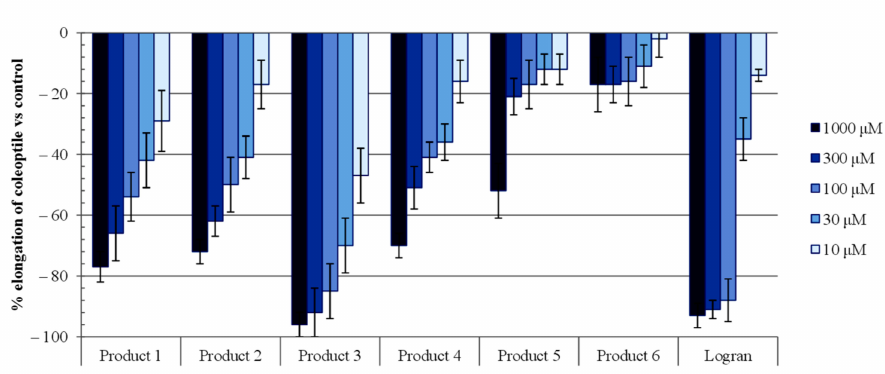
Figure 5. The effects of compounds ( 1 – 6 ) from Moquiniastrum pulchrum and triasulfuron sherbicide (Logran) on the elongation of etiolated wheat coleoptiles. Values are expressed as the percentage difference from the control. Each bar is the mean ± standard deviation.